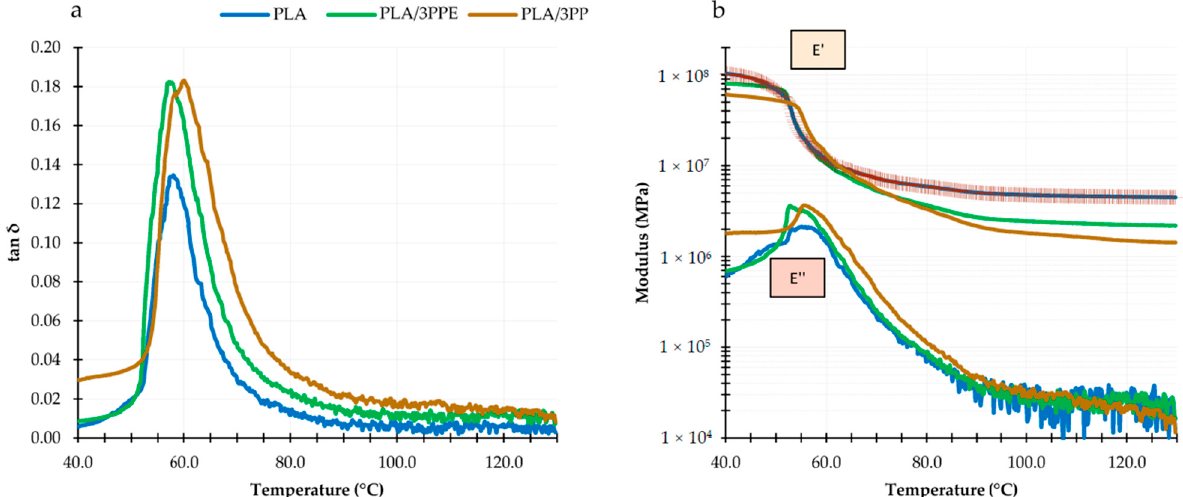
Figure 4. DMA curves of PLA, PLA/3PPE, and PLA/3PP in MD direction: tan δ ( a ) and storage (E ′ ) and loss (E ″ ) modulus ( b ).